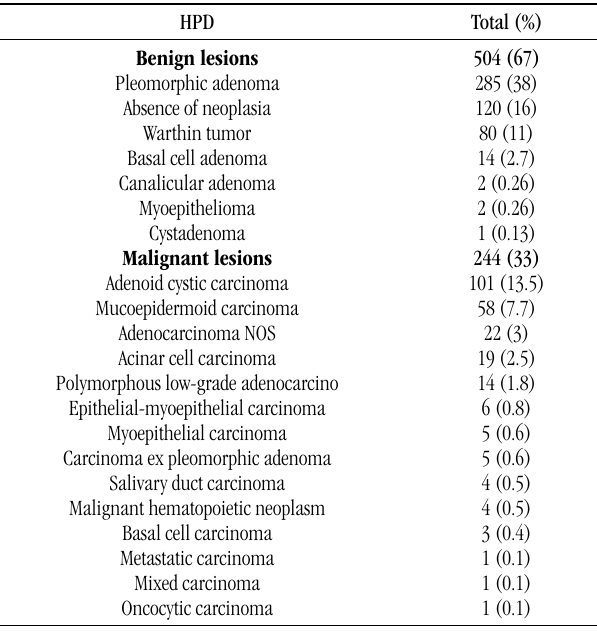
taBLE 5 – IOC in salivary gland lesions at Inca, from January 2001 to February 2012. Lesions were separated into benign and malignant, and according to histological classification ( n = 748)